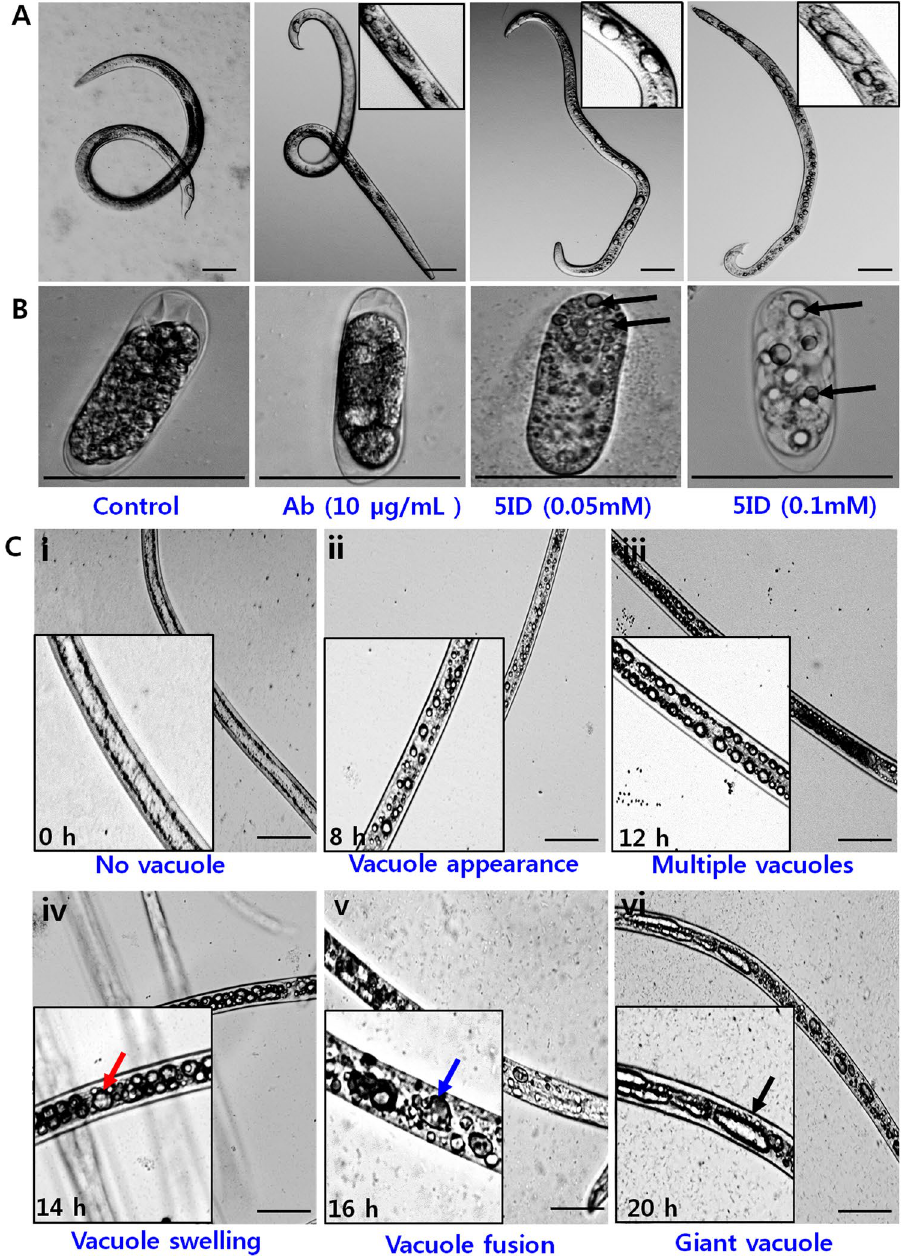
Figure 4. Effect of 5-iodoindole on vacuolization and methuosis in B . xylophilus . ( A ) Effects of abamectin and 5-iodoindole on adult male nematodes, ( B ) L1 stage nematode egg, and ( C ) Methuosis in B . xylophilus , (i) no vacuoles were observed at 0 h, treatment resulted in (ii) vacuolar appearance, (iii) multiple vacuole accumulation, (iv) vacuolar swelling, (v) vacuole fusion, and (vi) the formation of giant vacuoles. Red arrow indicates vacuole swelling, blue arrow indicates vacuolar fusion, and black arrow indicates a giant vacuole. Scale bars = 50 µ